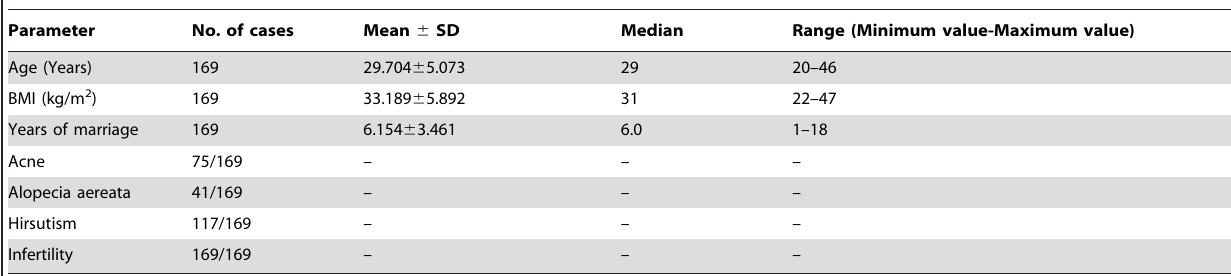
Table 1. Demographic features of PCOS